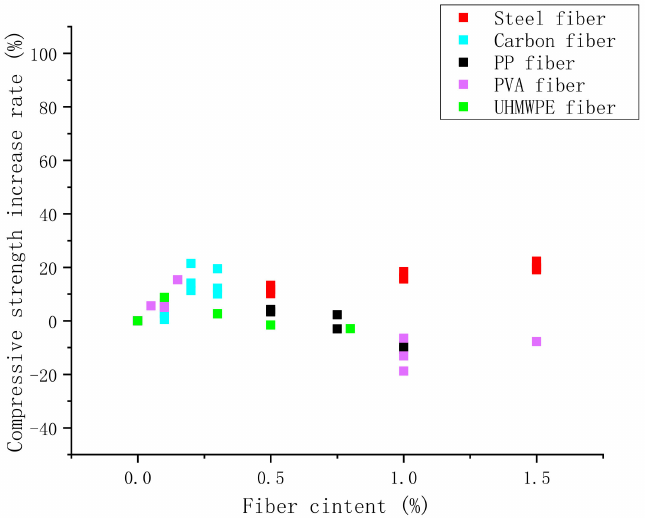
Figure 5. Effect of fiber types and content on the compressive strength of RAC: Steel fiber [64]; Carbon fiber [65]; PP fiber [67]; PVA fiber [68,69]; UHMWPE fiber